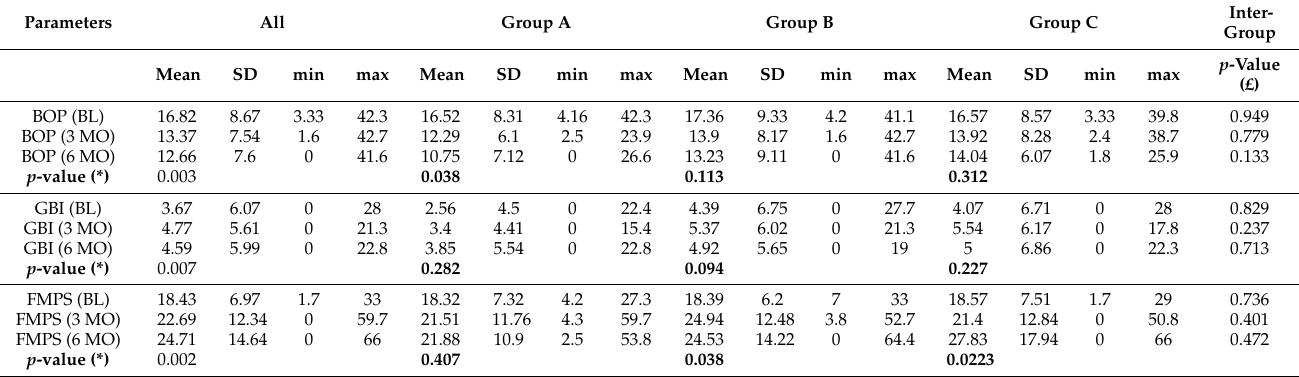
Table 2. Full mouth scores: bleeding on probing (BOP, %), gingival bleeding score (GBI, %), and plaque score (FMPS, %).